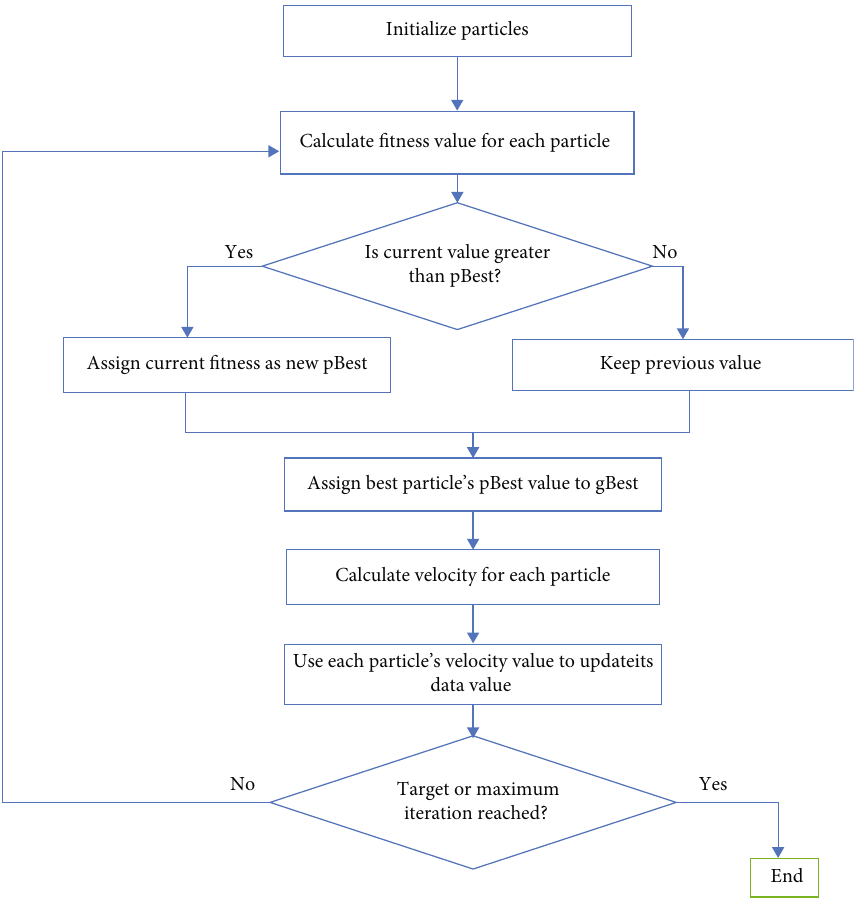
Figure 4: Flowchart for the PSO